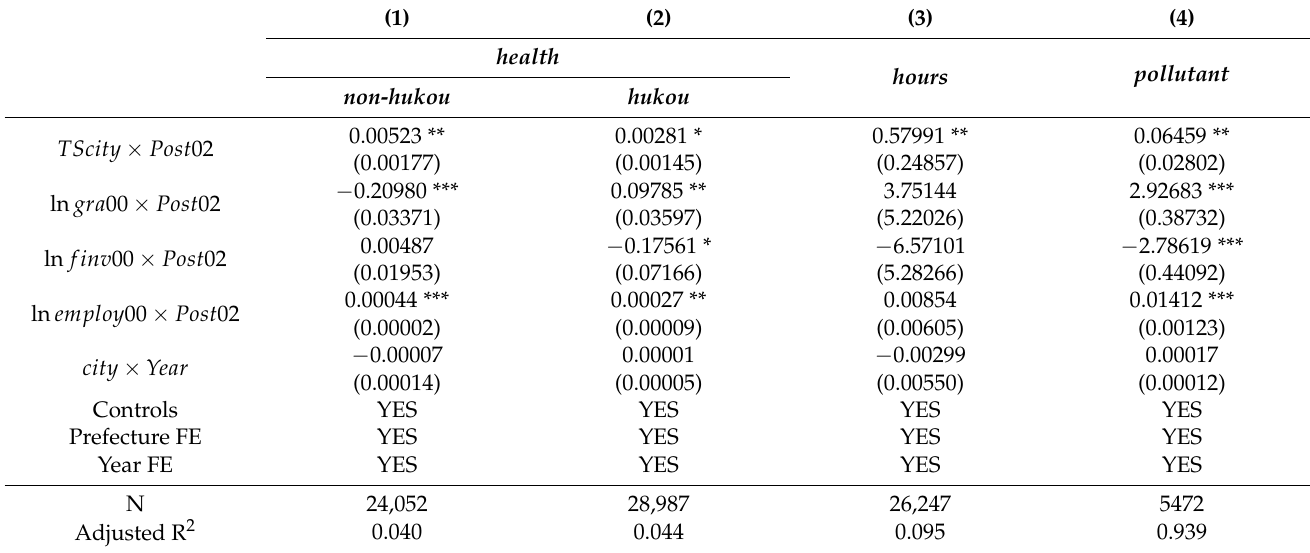
Table 7. Testing for channels of influence on health